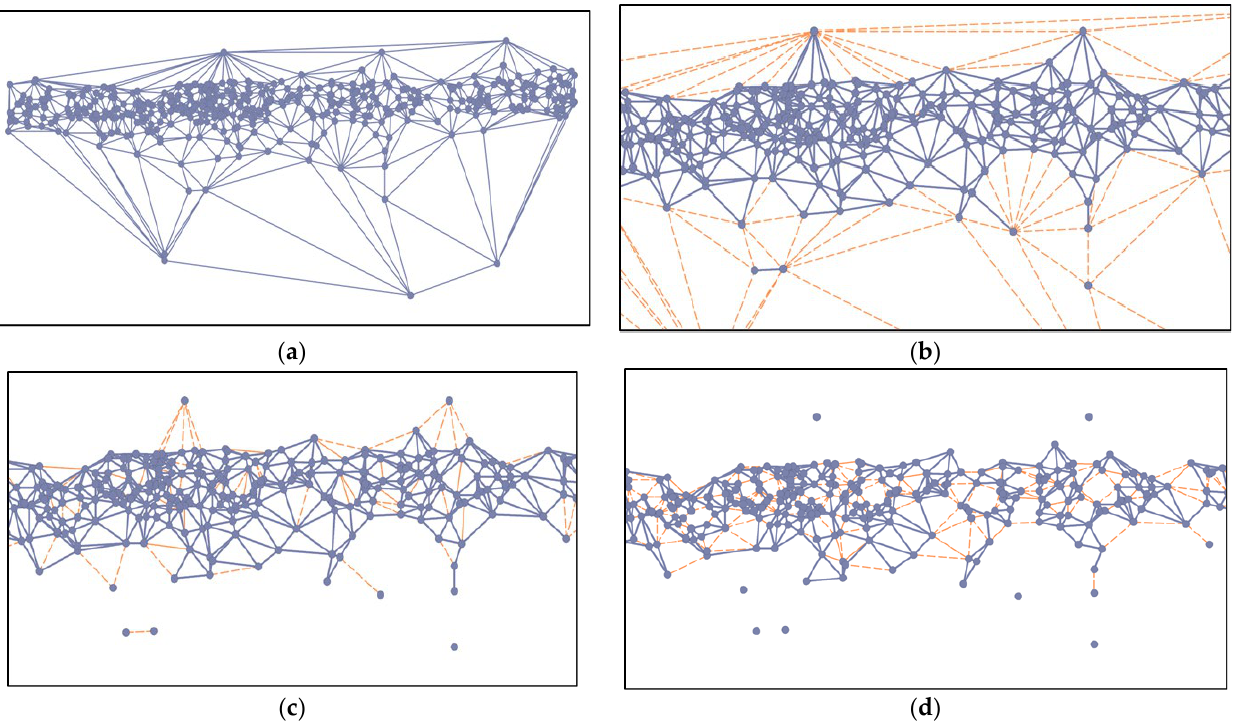
Figure 3. Schematic of ASCDT algorithm. ( a ) Delaunay triangulation; ( b ) global length constraint; ( c ) local length constraint; ( d ) local aggregation constraint.